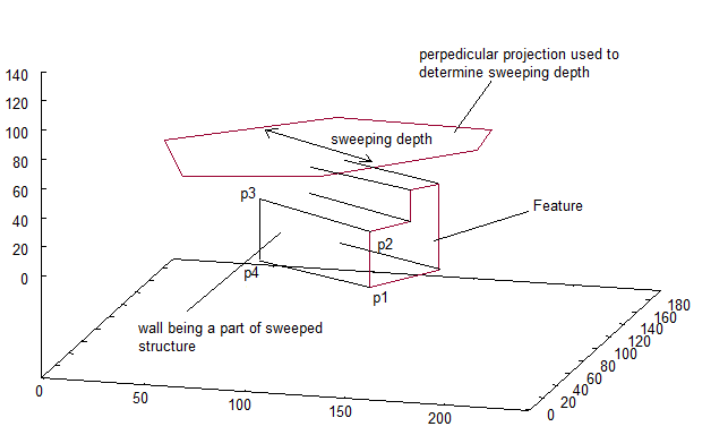
Figure 6. Process of feature